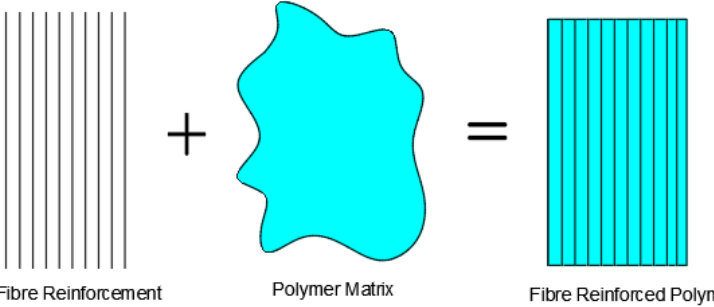
Figure 1. Composition of FRP composites [16].